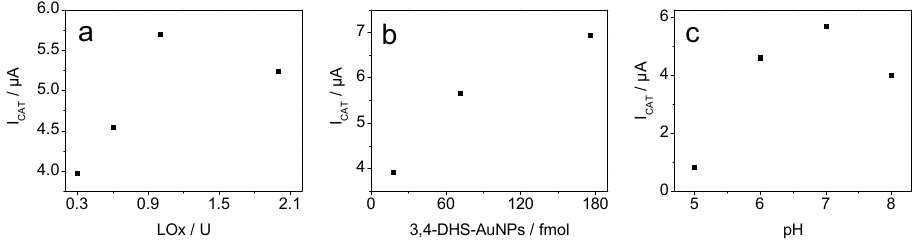
Figure 4. ( a ) Biosensor current response at different loadings of LOx enzyme in 0.1 M phosphate buffer (pH 7) containing 0.5 mM of lactate. Effect of ( b ) 3,4DHS–AuNP concentration and ( c ) pH on the